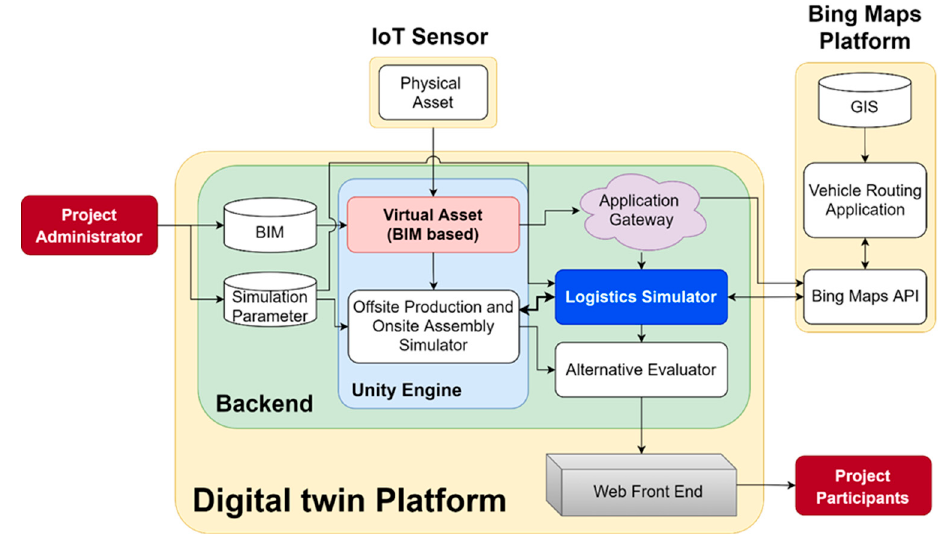
Figure 2. System architecture of the digital twin platform for logistics simulation.